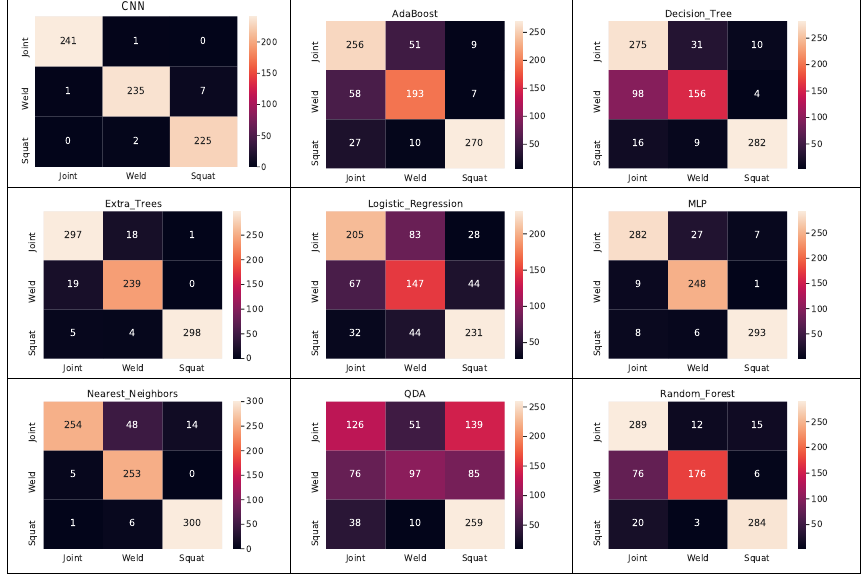
Figure 17. Classifiers’ confusion